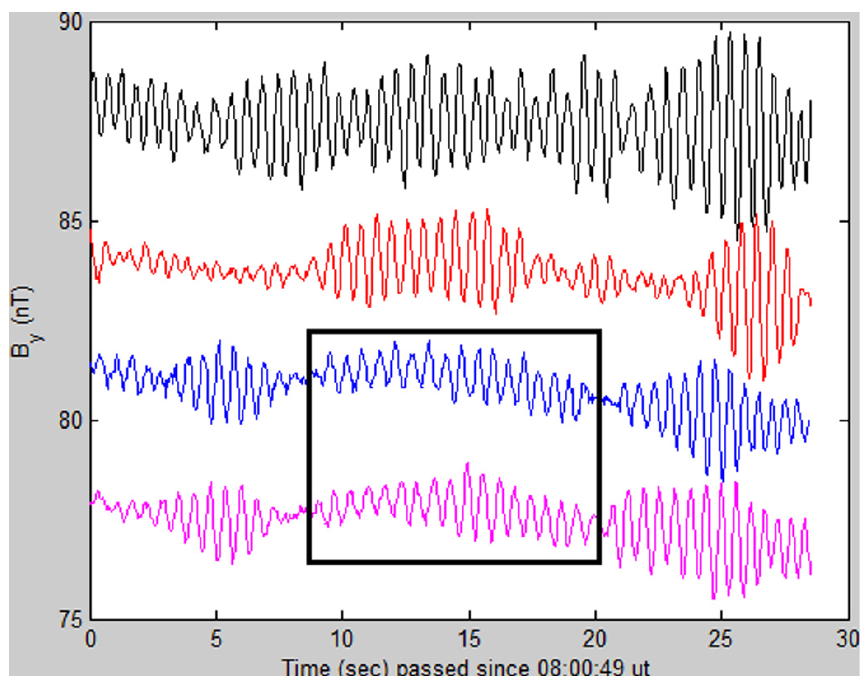
Fig. 3. Time series data of fluxgate magnetometer (FGM) instrument on board Cluster 1 (blue), Cluster 2 (red), Cluster 3 (black) and Cluster 4 (magenta) showing wave packets 49s after 08:00UTC. B y axis shifted + 5nT for Cluster 3 and − 5nT for Cluster 4 for better viewing. The black rectangle is around the 2 simultaneous measurements which were